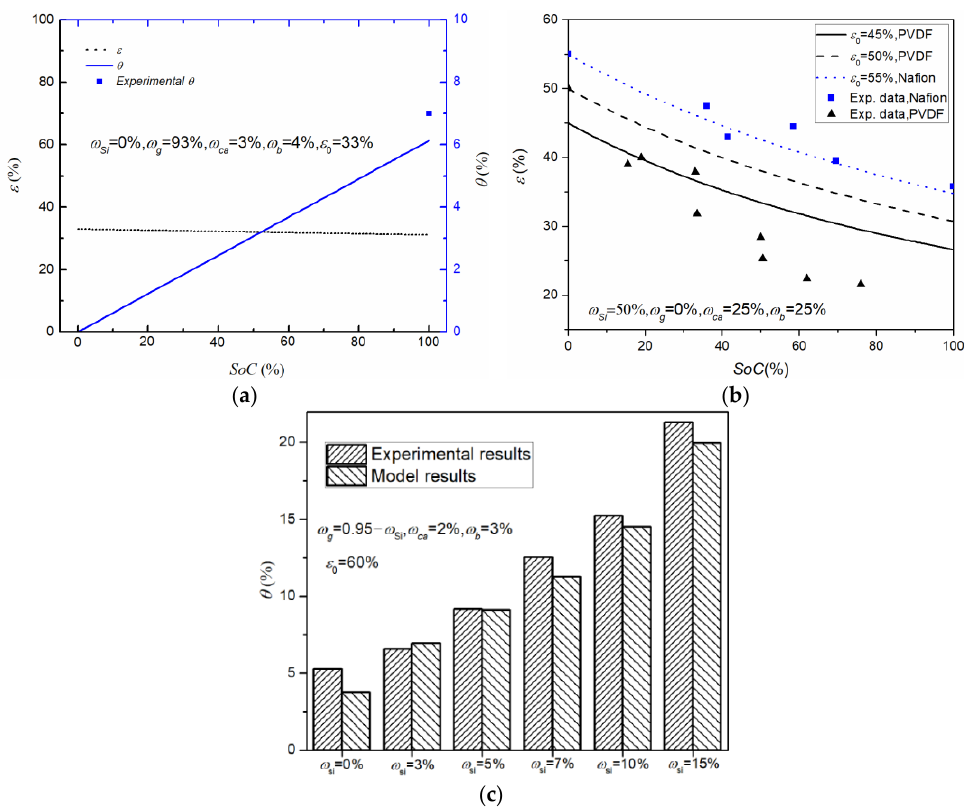
Figure 2. ( a ) The evolution of porosity and volume change for graphite anodes during lithiation. ( b ) The evolution of porosity for Si-based composites during lithiation. ( c ) The volume change of Si/graphite composites with different ratios at full lithiation. Here, the experimental data are collected from the previous reports [14,30,57].